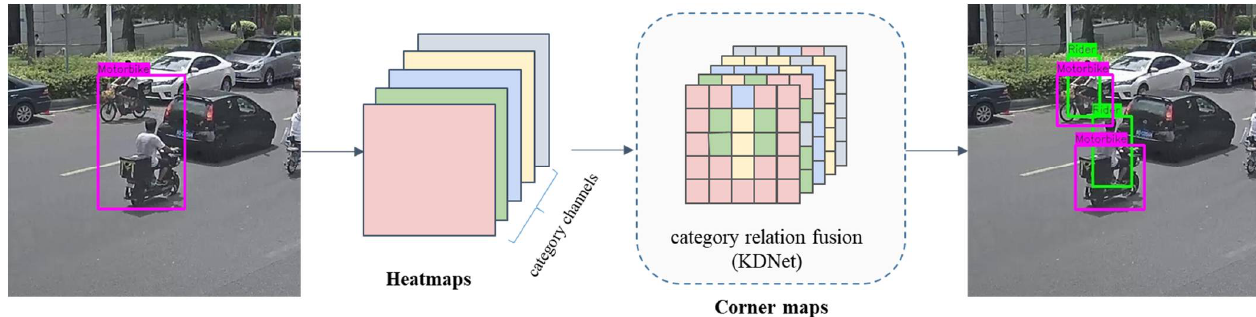
Figure 1. A deficiency of a traditional anchor-free object detection framework. Shown in the first image, the anchor-free network detects two riders as the same object. There are two reasons for this: (1) The process of detecting objects is independent, and it is not possible to assign corresponding weight to the current detection when detecting an object; thus, the network does not learn the relationship between objects. (2) In the algorithm based on keypoint detection, the heatmaps are the keypoints of each object independently. Therefore, in order to better integrate the information between each category channel of heatmaps, we propose a knowledge-driven network (KDNet) to aggregate and model the relationship between keypoints and apply the information of each category channel of heatmaps to establish relationships between all categories. Finally, KDNet has fused category relation information to obtain the final detection